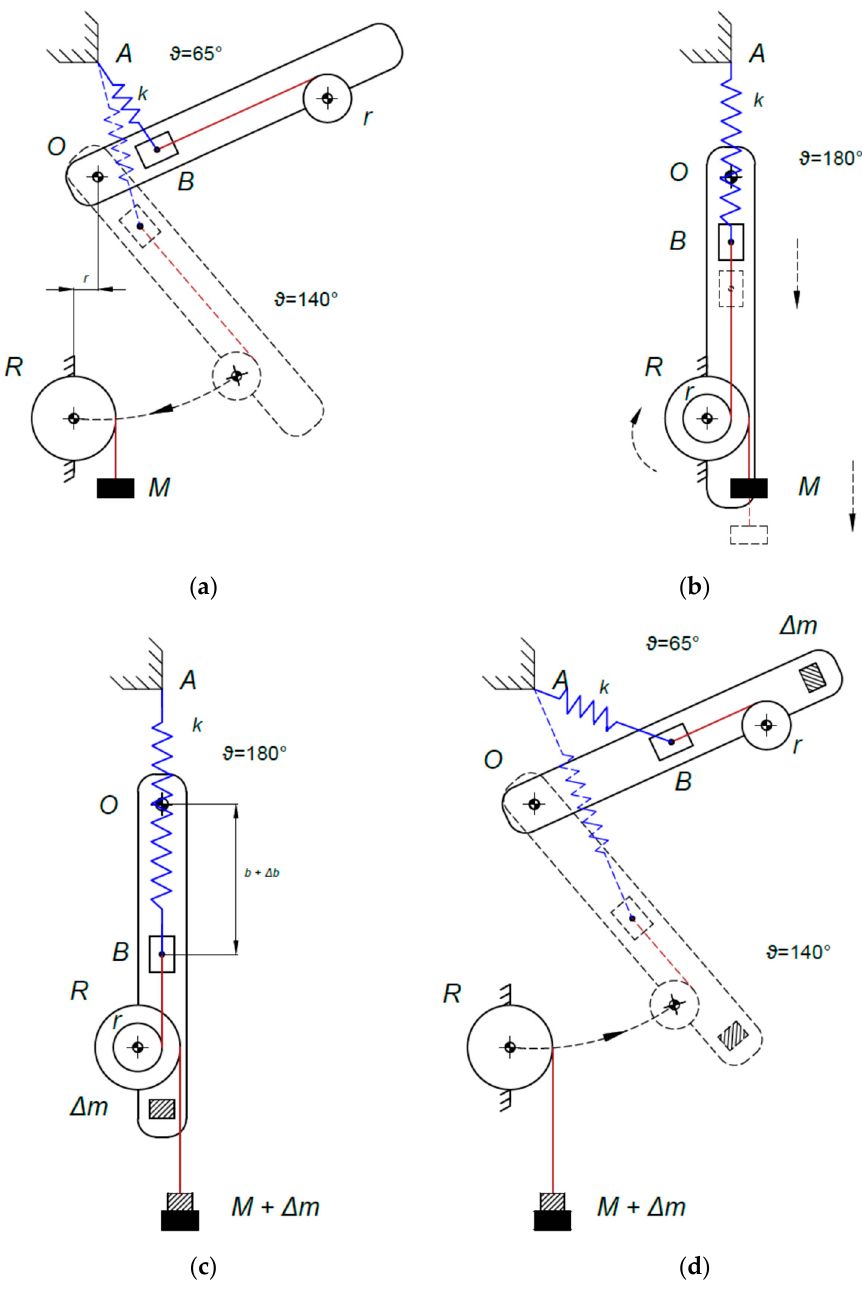
Figure 4. ( a ) The system is in indifferent equilibrium, and the auxiliary mechanism is fixed to the frame; ( b ) The link is fixed on the auxiliary mechanism. ( c ) Variation of the load on the link and variation on the counterweight. ( d ) The system is in the new configuration of equilibrium, and the auxiliary mechanism is fixed on the frame.